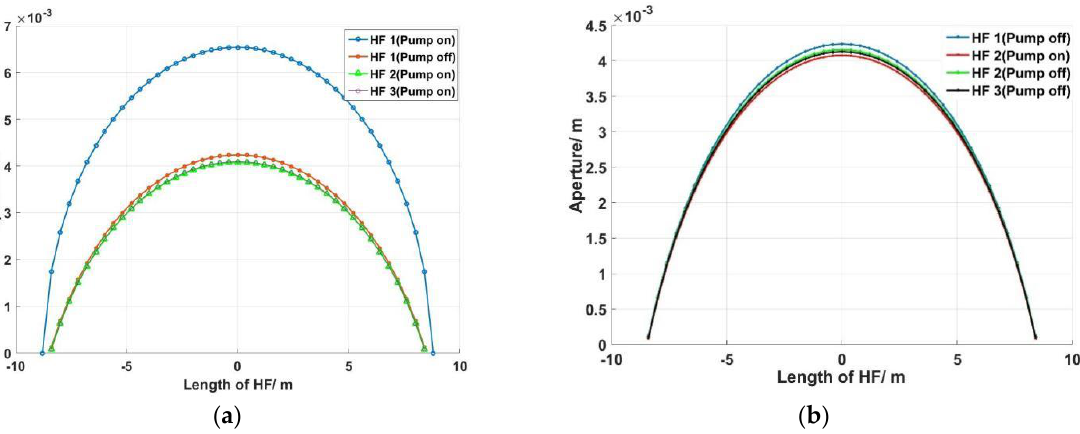
Figure 6. Aperture of hydraulic fracture 1. ( a ) in different fracturing stages; ( b ) in different shut off stages of the well.